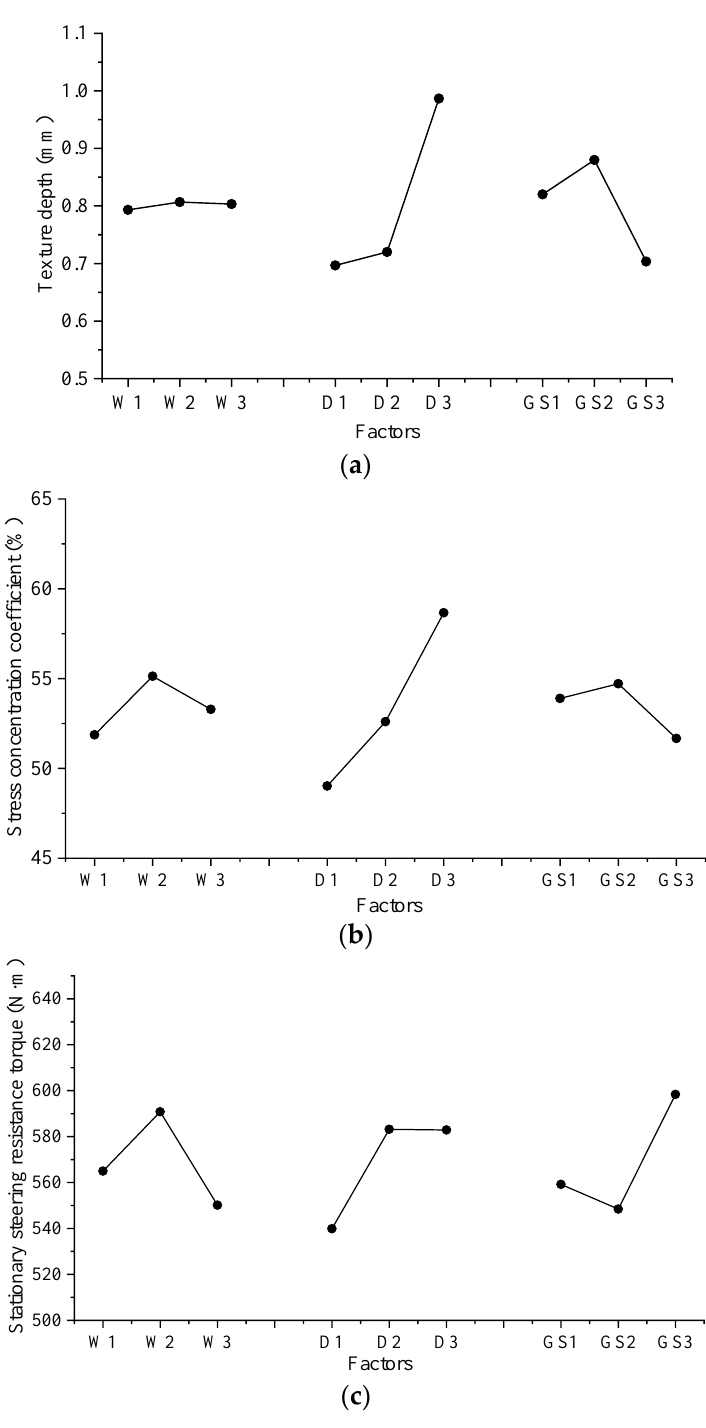
Figure 10. Average value per level for each factor: ( a ) texture depth; ( b ) stress concentration coefficient; ( c ) stationary steering resistance torque.